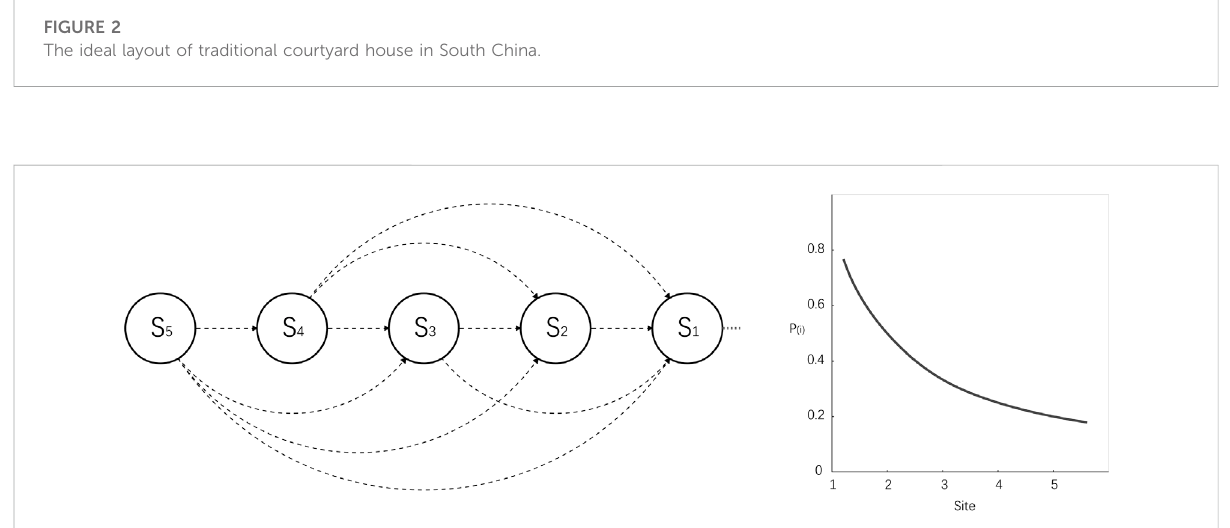
FIGURE 3 The mechanism of SSR process in traditional